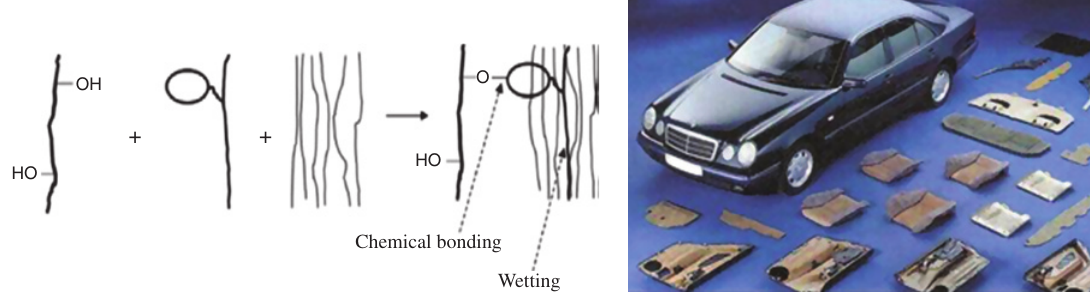
Figure 3: The interior components made of a natural fiber compos- ite for an E-class car